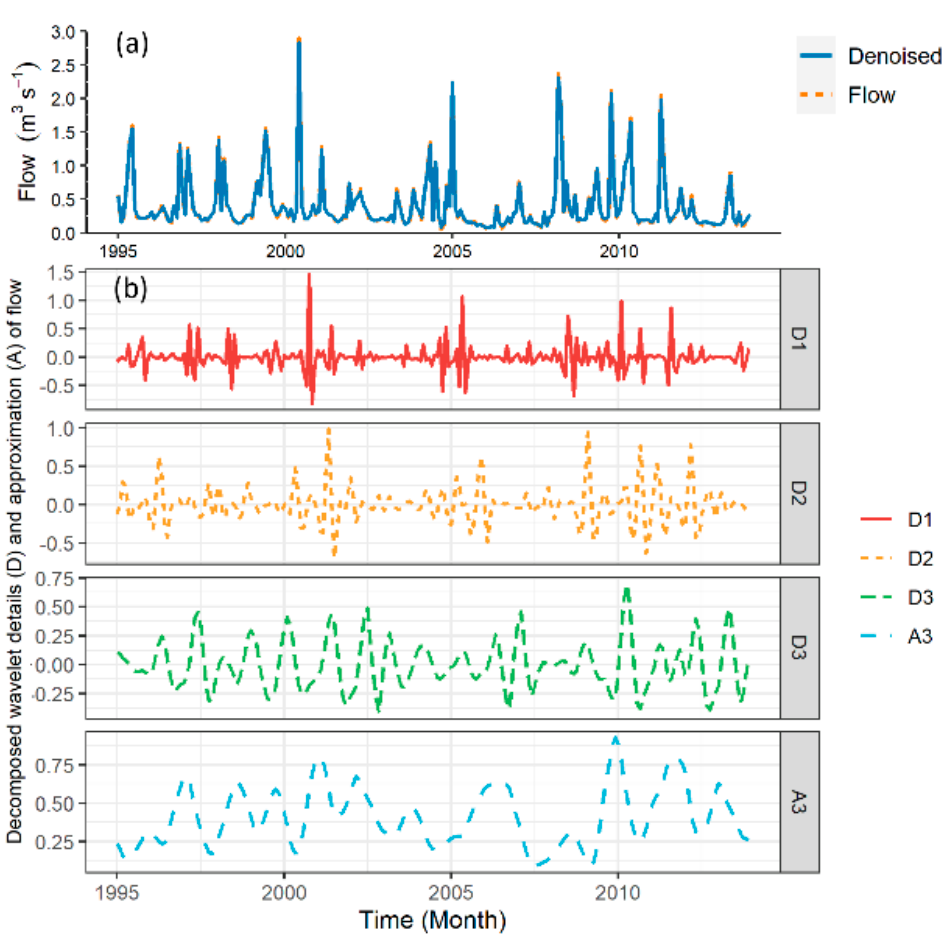
Figure 4. An example of the flow DWT at 07195430 site: ( a ) Observation and SWAT-CUP simulation, ( b ) wavelet decomposition.